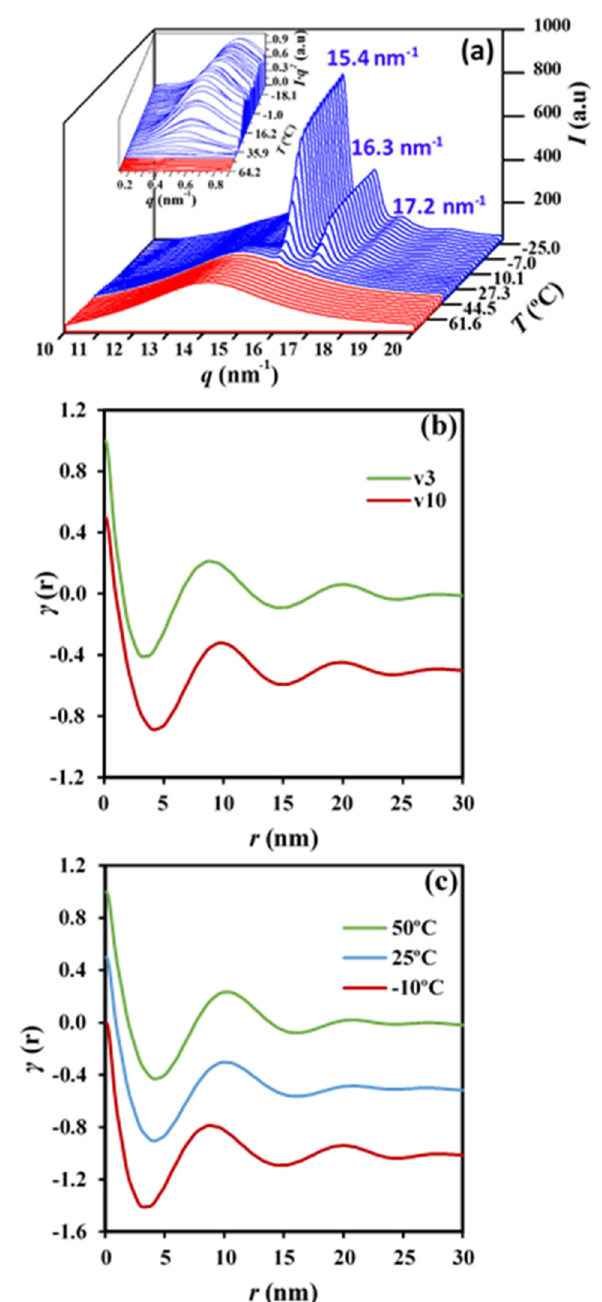
Figure 13. ( a ) Three-dimensional wide-angle X-ray diffraction (WAXD) and small-angle X-ray scattering patterns (SAXS) profiles of P4HB during cooling at a rate of 7 °C/min. ( b ) Correlation functions obtained after non-isothermal crystallizations of P4HB from the melt state performed at cooling rates of 3 and 10 °C/min. ( c ) SAXS correlation functions calculated at the indicated temperatures during the cooling run (3 °C/min) of a melted P4HB sample.